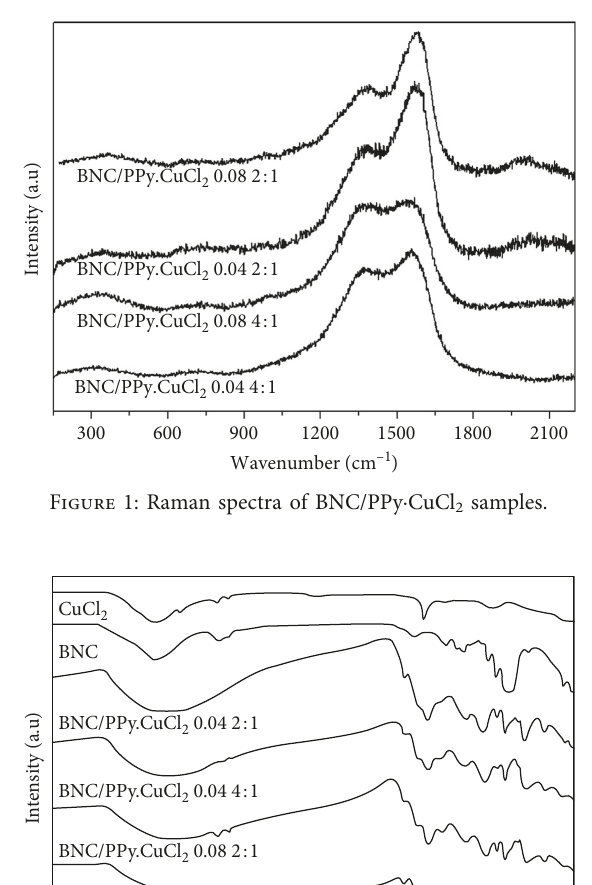
2 , and BNC/PPy · CuCl 2